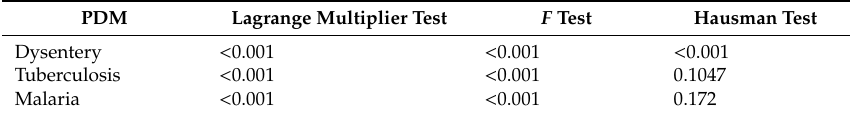
Table 4. p -values of Lagrange Multiplier Test, F Test, and Hausman Test.